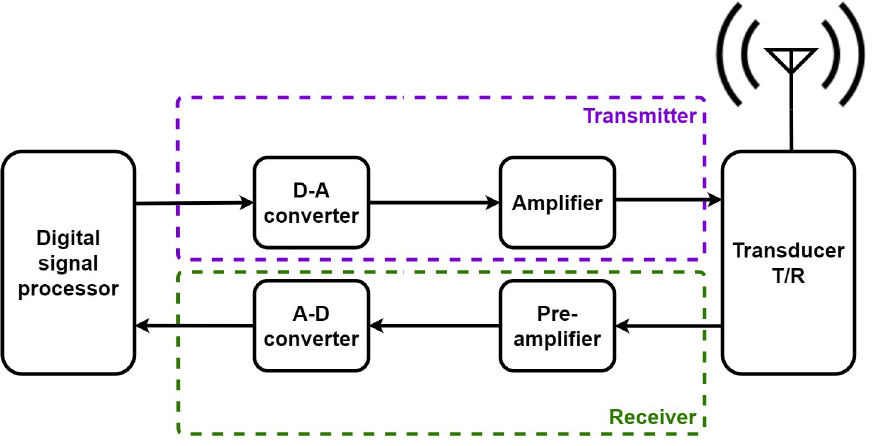
Fig 1. Wireless ultrasonic system block diagram